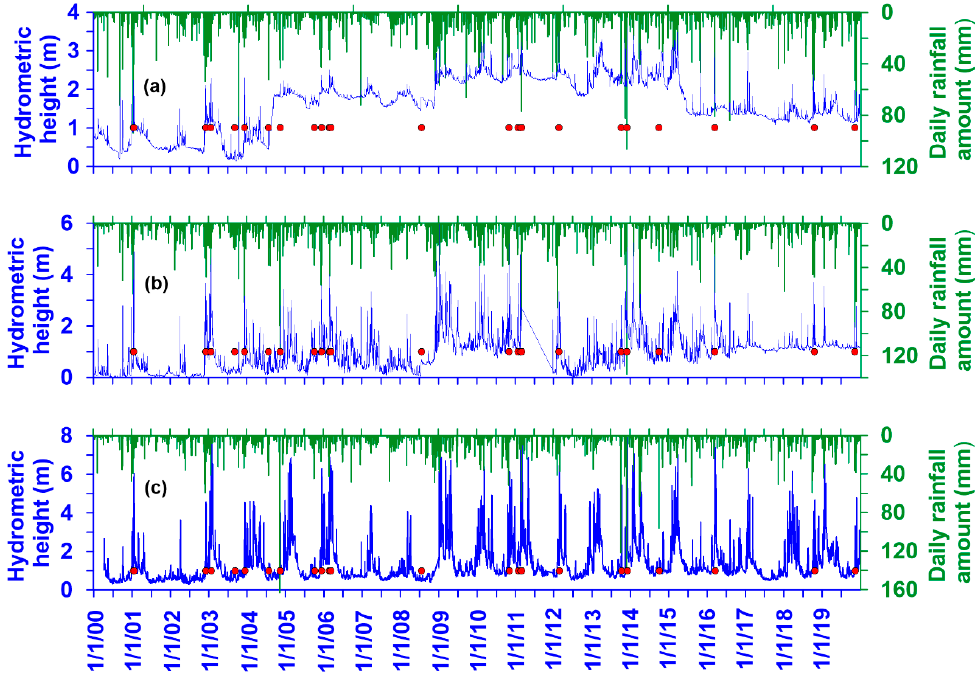
Figure 4. Daily hydrometric height (m) of Sinni River ( a ), Cavone River ( b ), and Basento River ( c ) versus daily rainfall (mm) from 1 January 2001 to 31 December 2019 at the Sinni SS106, Terra Montonata, and Basento Freatimetro hydroclimatic stations. Circles in red indicate flood events.